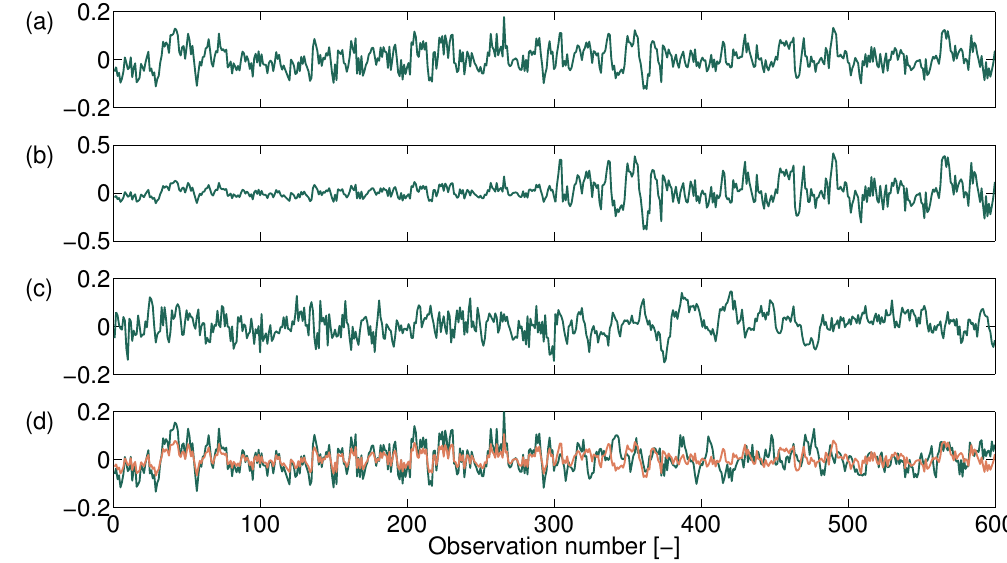
Figure 4. Illustration of changing vegetation response characteristics: ( a ) stationary time series; ( b ) time series with increasing standard deviation (SD); ( c ) time series with increasing auto-correlation (AC); ( d ) two time series with decreasing correlation